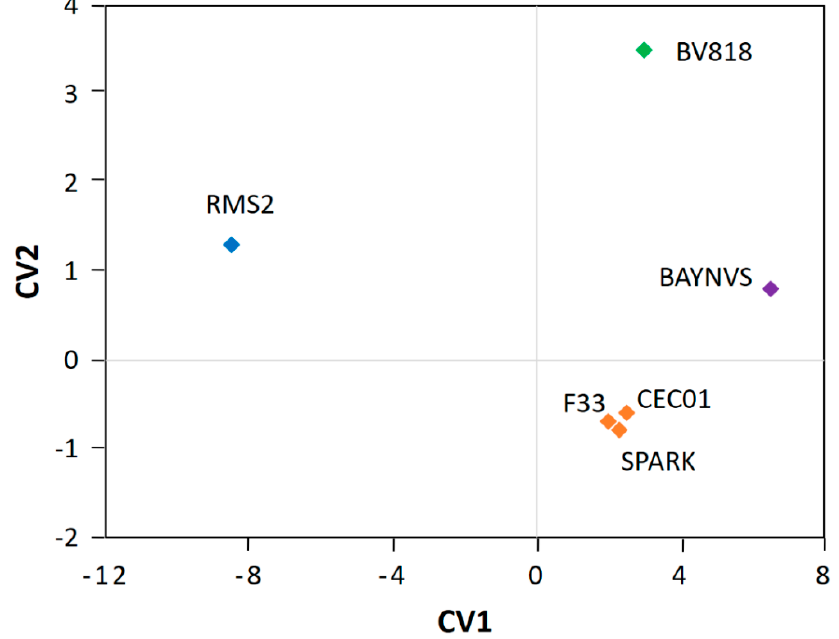
Figure 3. Canonical correlation analysis (CCA) of similarity of the jujube wine produced by the six winemaking yeasts. The plot was defined by canonical variates 1 and 2.